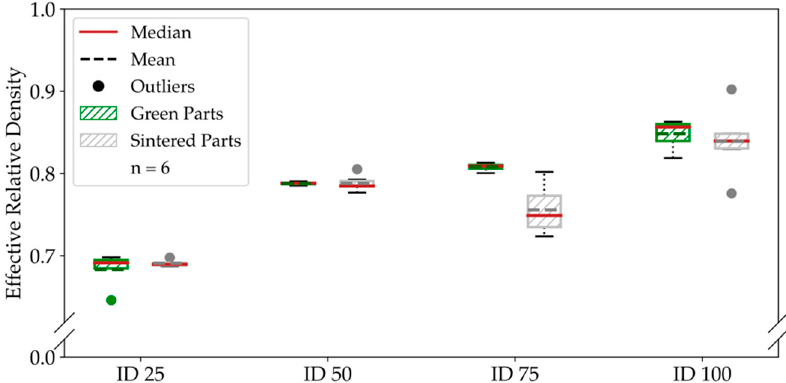
Figure 7. Effective relative density of the tensile specimens. The comparison of the tensile specimens’ density before and after sintering shows a constant relative density for ID 25 and ID 50 and a decrease for ID 75 and ID 100.